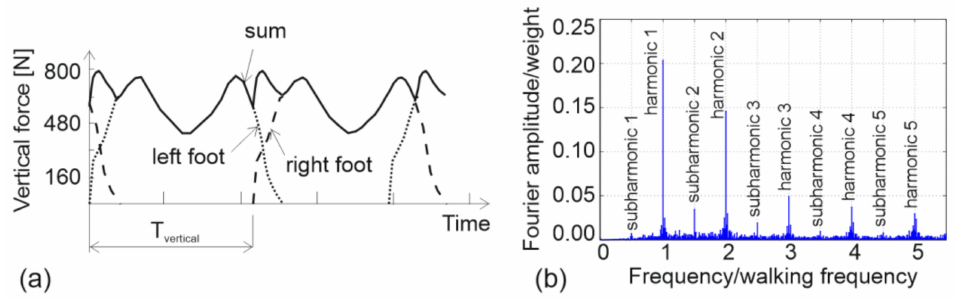
Figure 2. ( a ) Periodic GRF representation in the time domain and ( b ) actual GRF representation in the frequency domain (vertical component only).